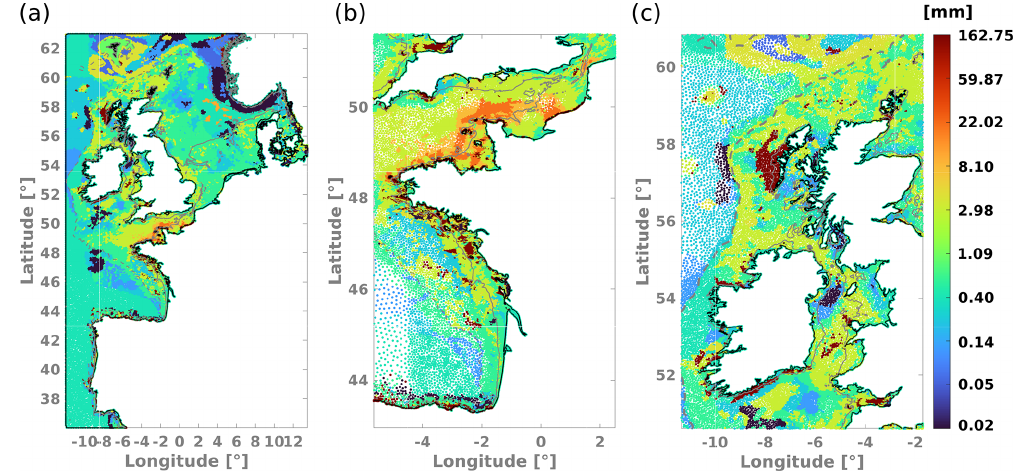
Figure 2. Bottom sediment size map. D 50 values assigned to each mesh node for (a) full domain, (b) Bay of Biscay and the English Channel, and (c) United Kingdom. Color bar represents D 50 in millimeters. Gray dashed lines represent 20m depth contours; continuous gray lines represent 50m depth